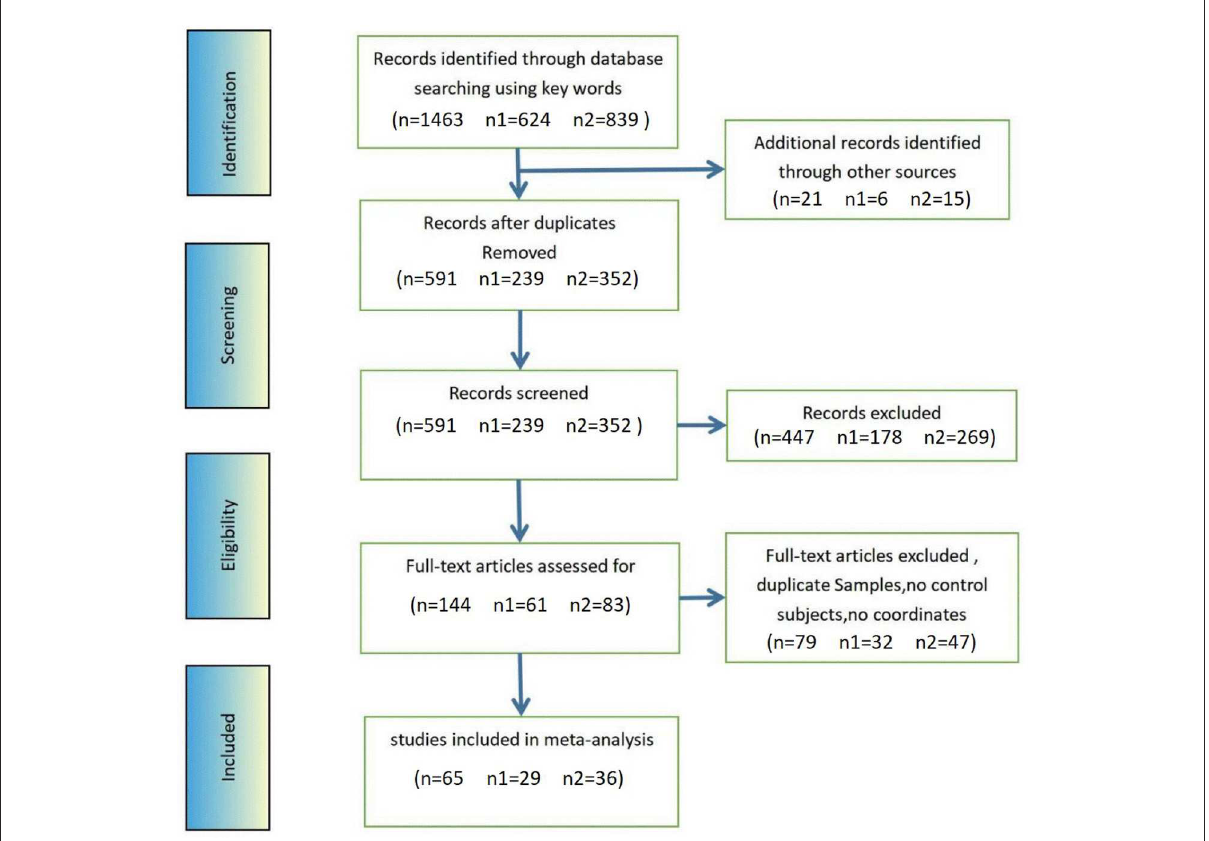
FIGURE1 Methods and results of literature search for ADHD fMRI and VBM. n , total number of studies; n 1, number of VBM study; n 2, number of fMRI